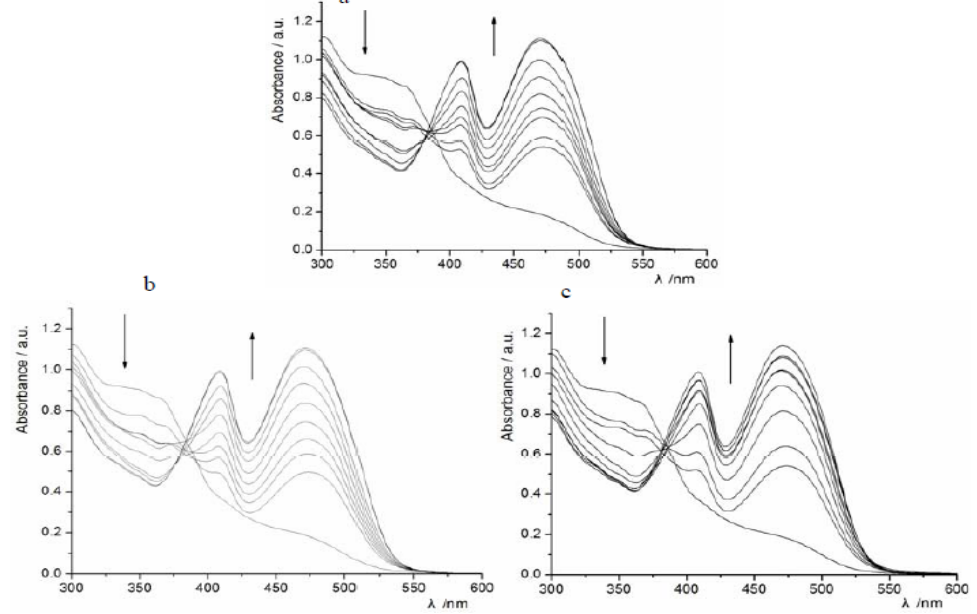
Figure 1. UV-vis spectral changes of compound 1 (4.0 × 10 − 5 mol·L − 1 ) upon the addition of anions (0–160 × 10 − 5 mol·L − 1 ), ( a ) H of increasing anion concentration.